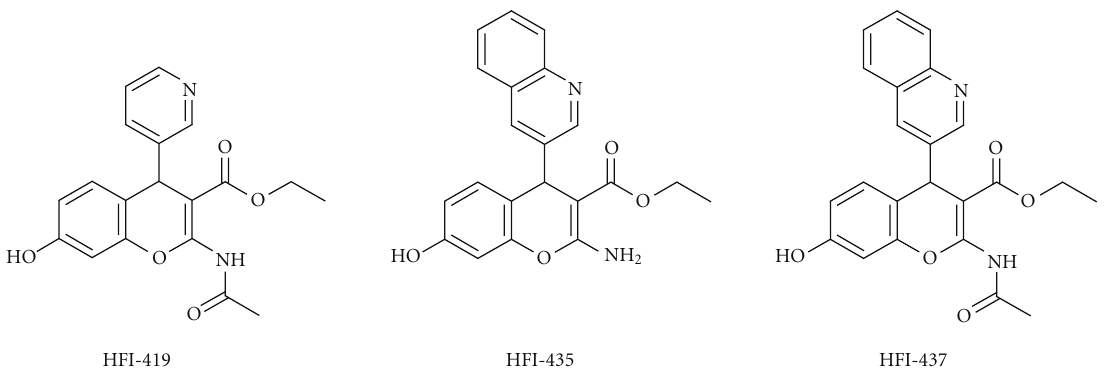
Figure 14: Recently identified potent non-peptidic IRAP inhibitors with a benzopyran sca ff